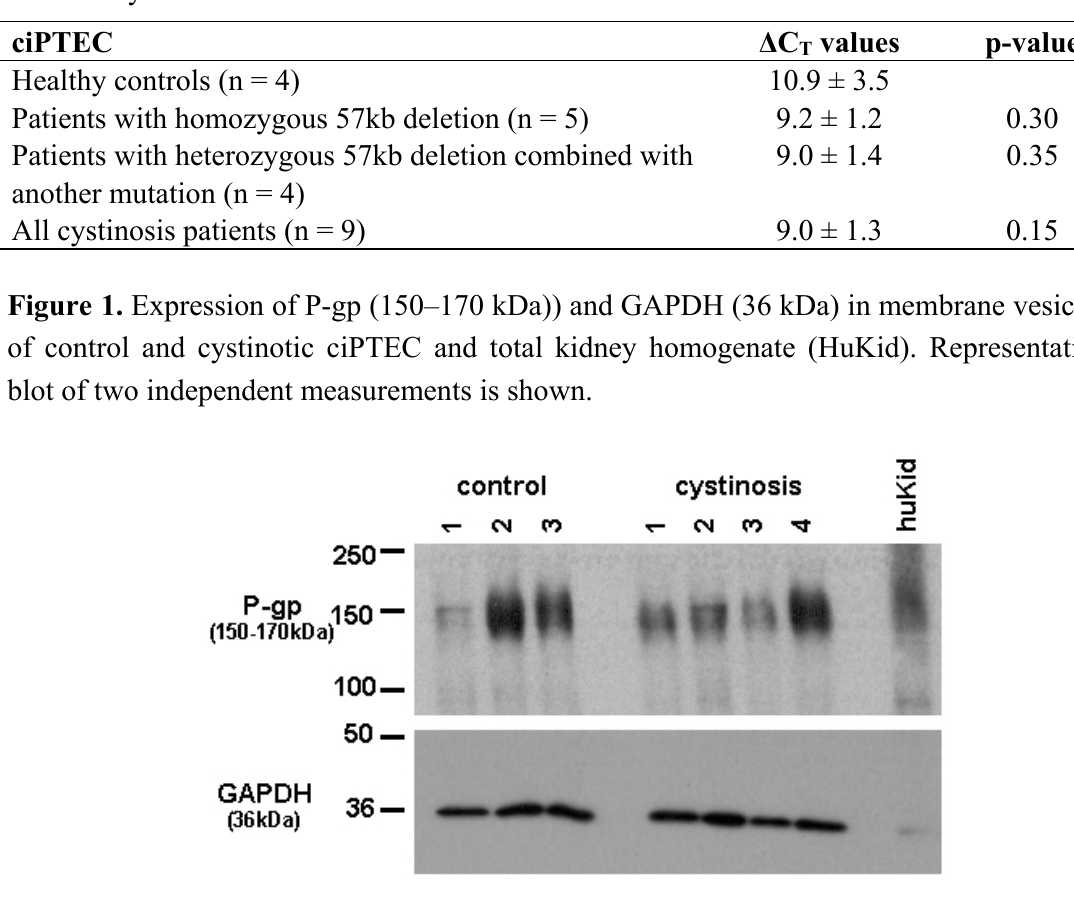
Table 1 . P-gp mRNA expression in (ci) proximal tubular epithelial cells (ciPTEC) of cystinosis patients and healthy controls. Data of 13 samples, measured in triplicate, are presented. ∆ C(t) values are corrected for the expression of β -Actin, which was used as an internal control (mean C(t) β -Actin: C(t) = 18.1 ± 0.9). β -Actin mRNA expressions were